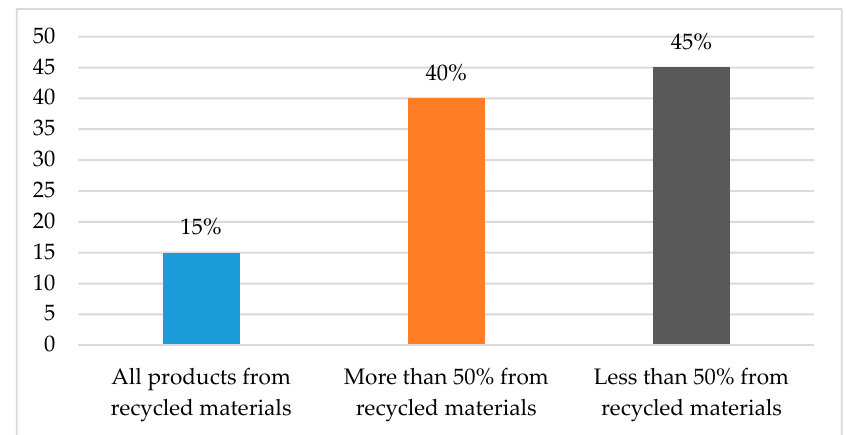
Figure 1. Part of the packaging production that is made from recycled raw materials in companies